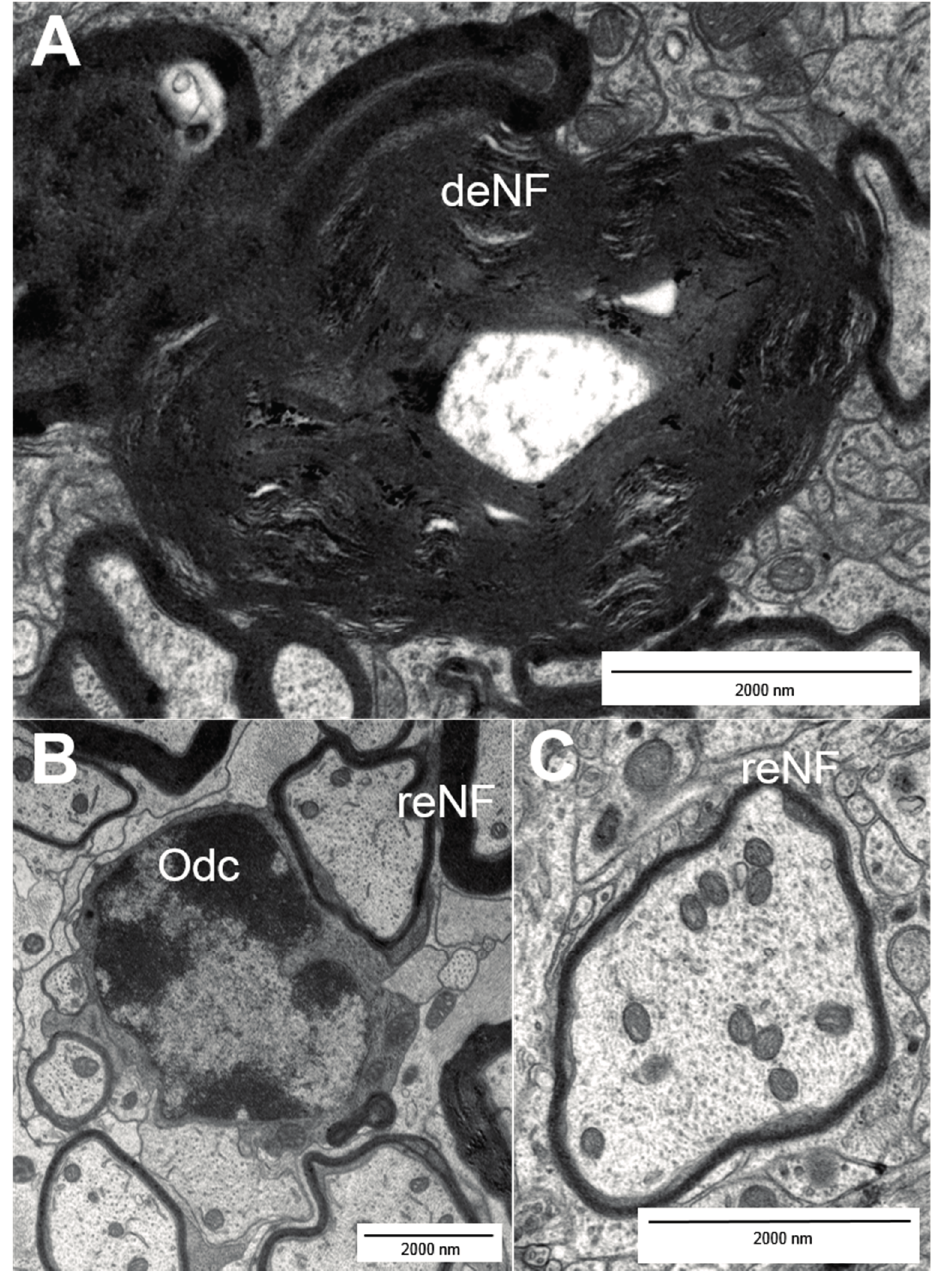
Figure 2. Myelination patterns of nerve fibers: ( A ) demyelinating nerve fibers (deNF); ( B ) olidodendrocytes (Odc); and ( B , C ) remyelinating nerve fibers